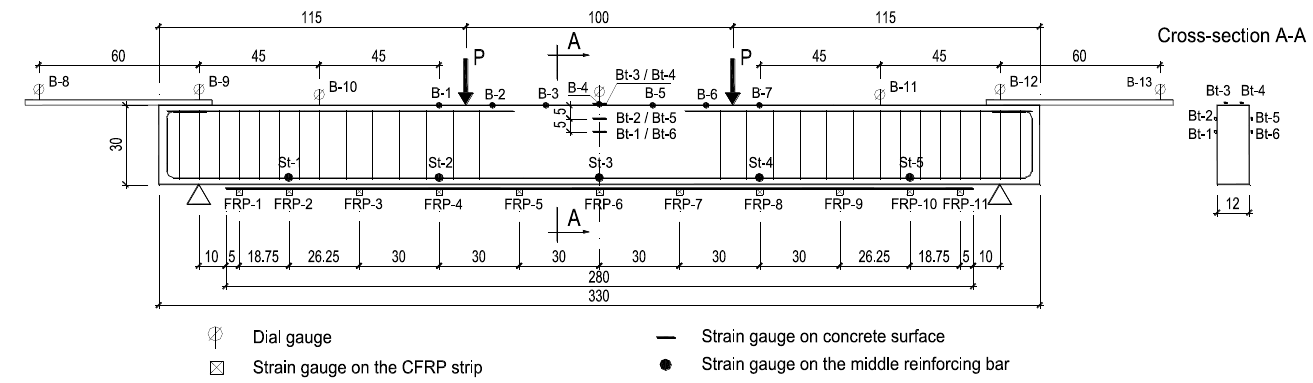
Figure 3. Arrangement of measurement points on all beams during experiments [2,3].